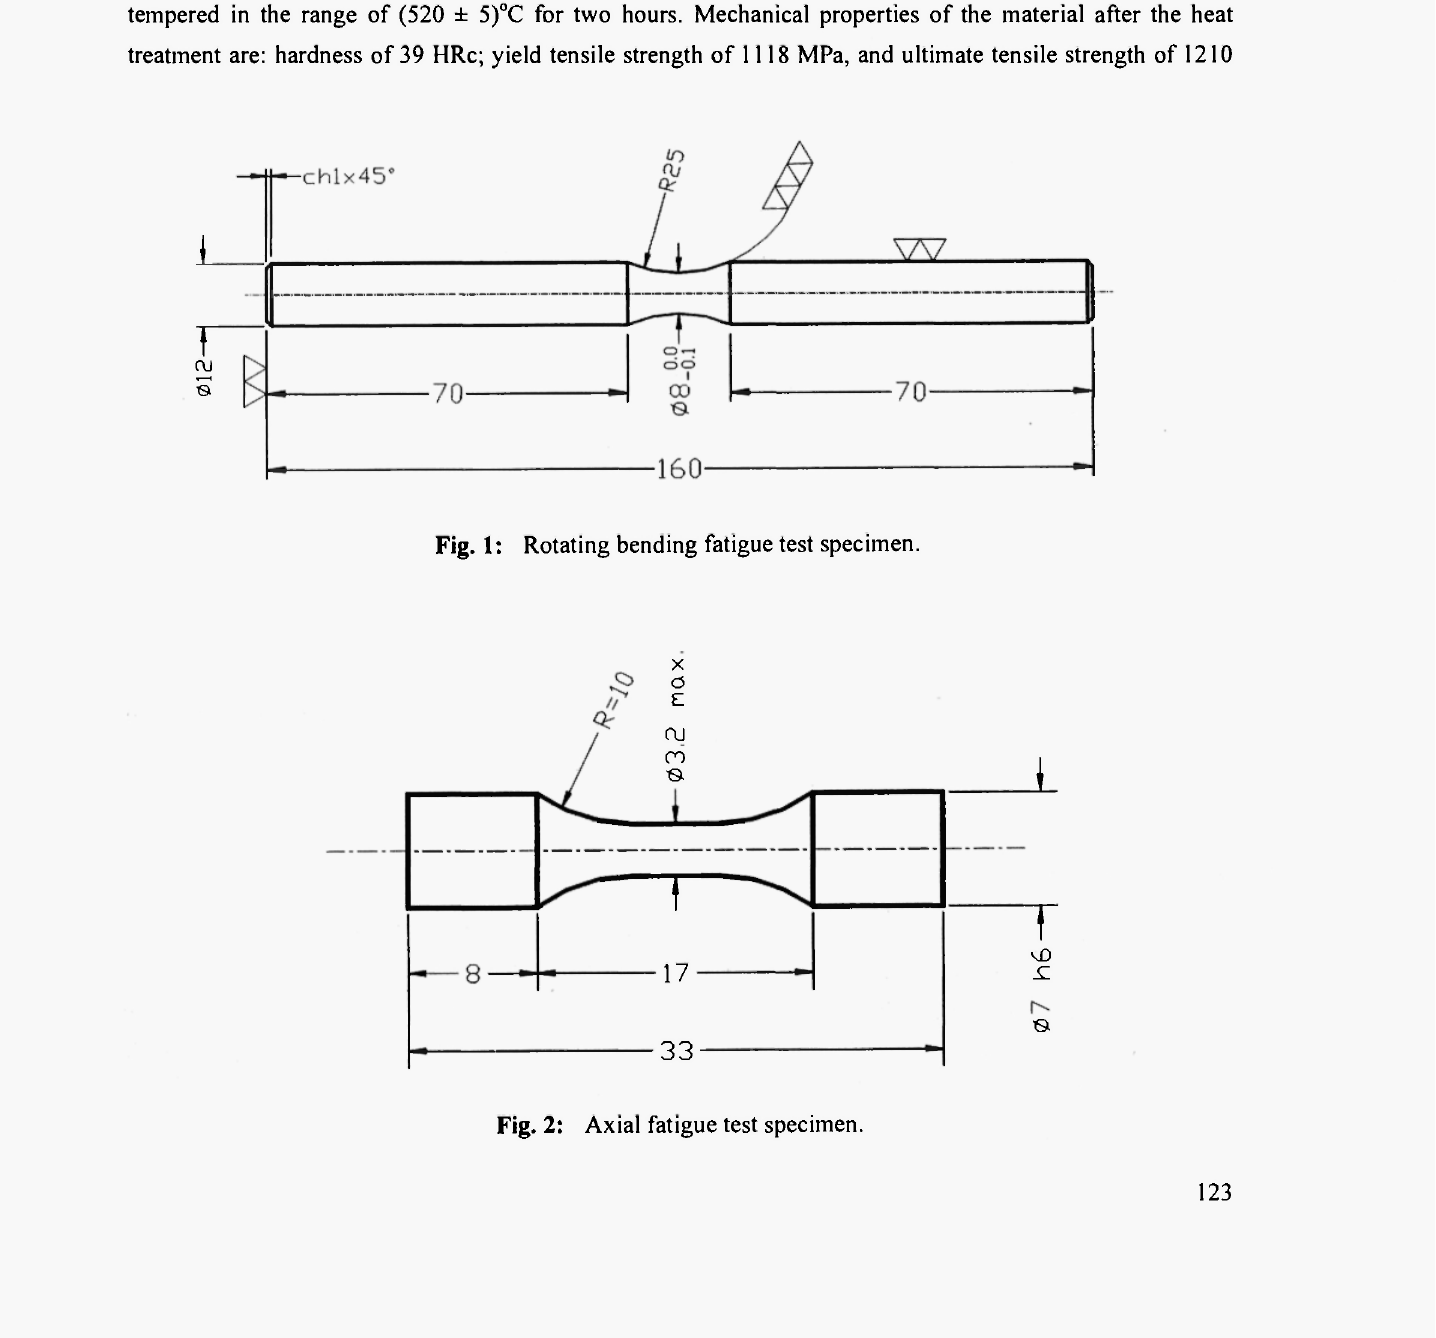
Fig. 2: Axial fatigue test